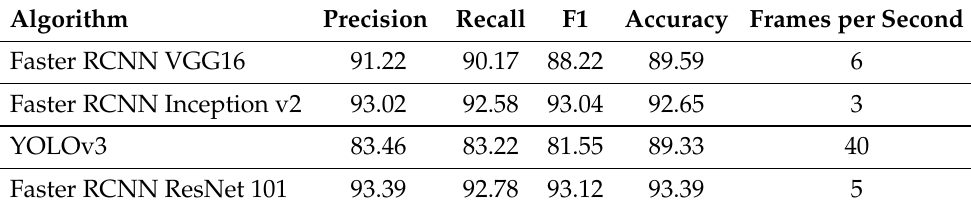
Table 3. Comparison